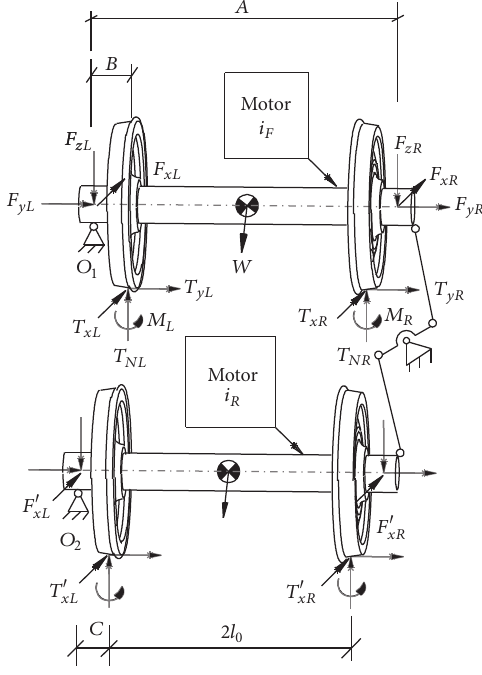
Figure 3: Force diagram of asymmetric radial